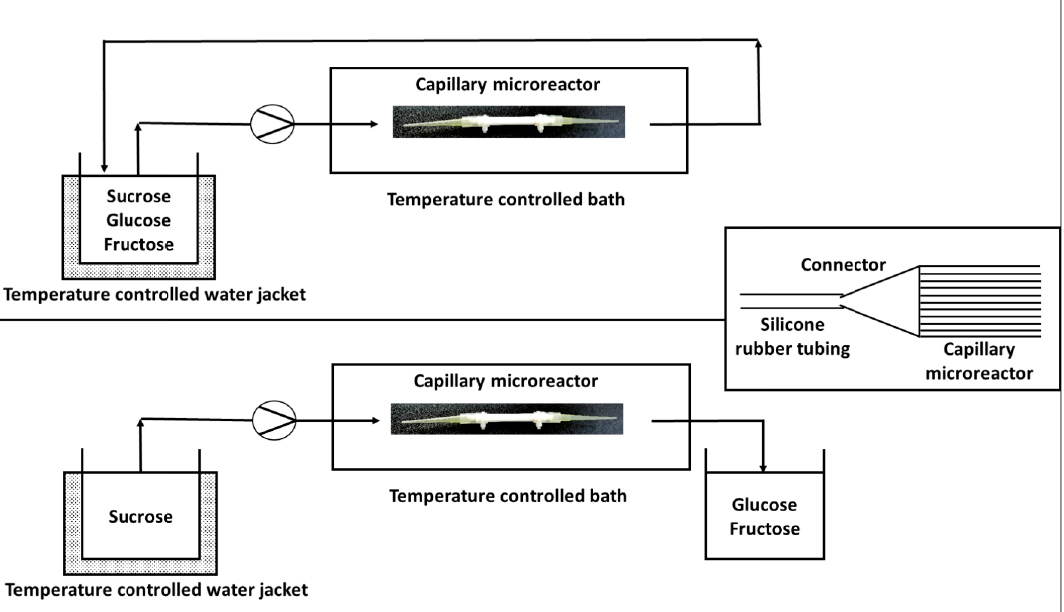
Figure 10. Schematic of the employed recirculation and continuous mode set ups. Substrate solutions were fed through the use of a peristaltic pump using silicone rubber tubing and temperature was controlled via immersion of the microchannel reactor in a water